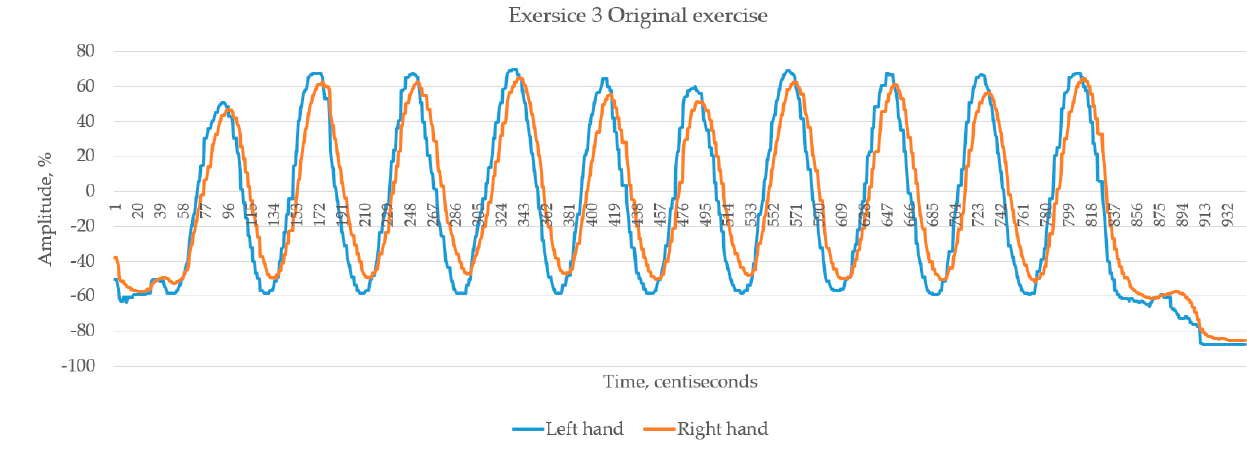
Figure 9. Result of normal performance in Exercise 3.